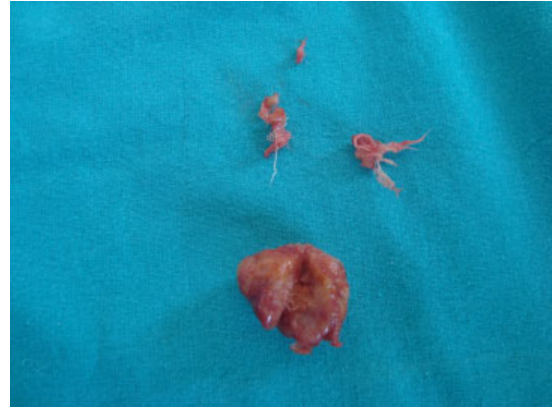
Fig. 2 Mass with sponge